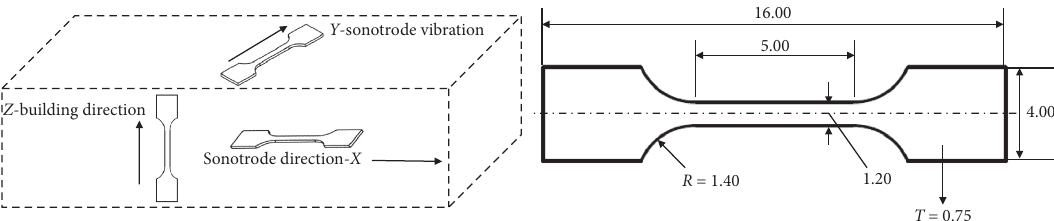
Figure 14: Schematic showing the sample extraction for mechanical testing and the dimensions of the tensile test samples (redrawn from [15]).